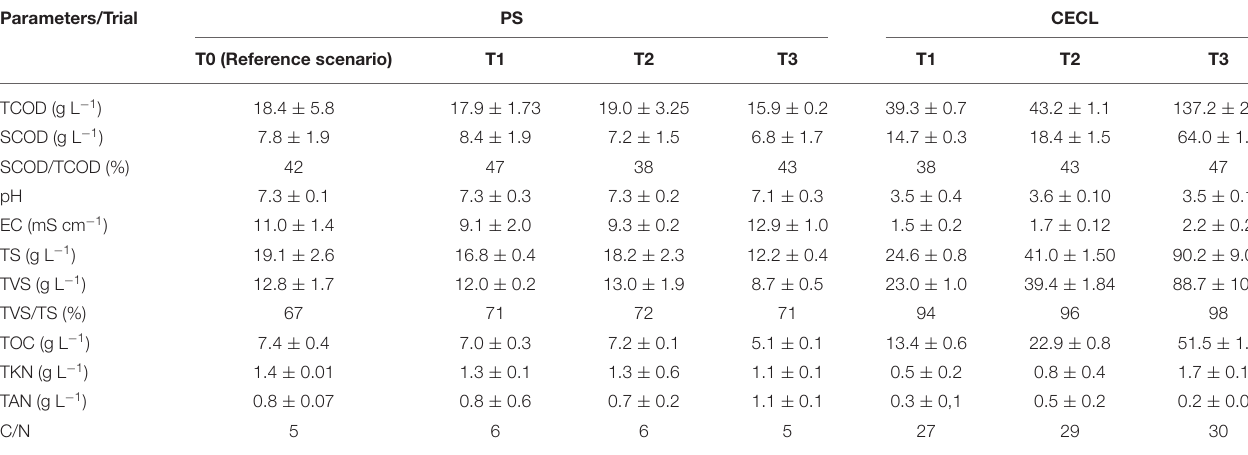
TABLE 2 | Characterization of the feeding mixtures and digestates of the trials performed. Parameters/Trials